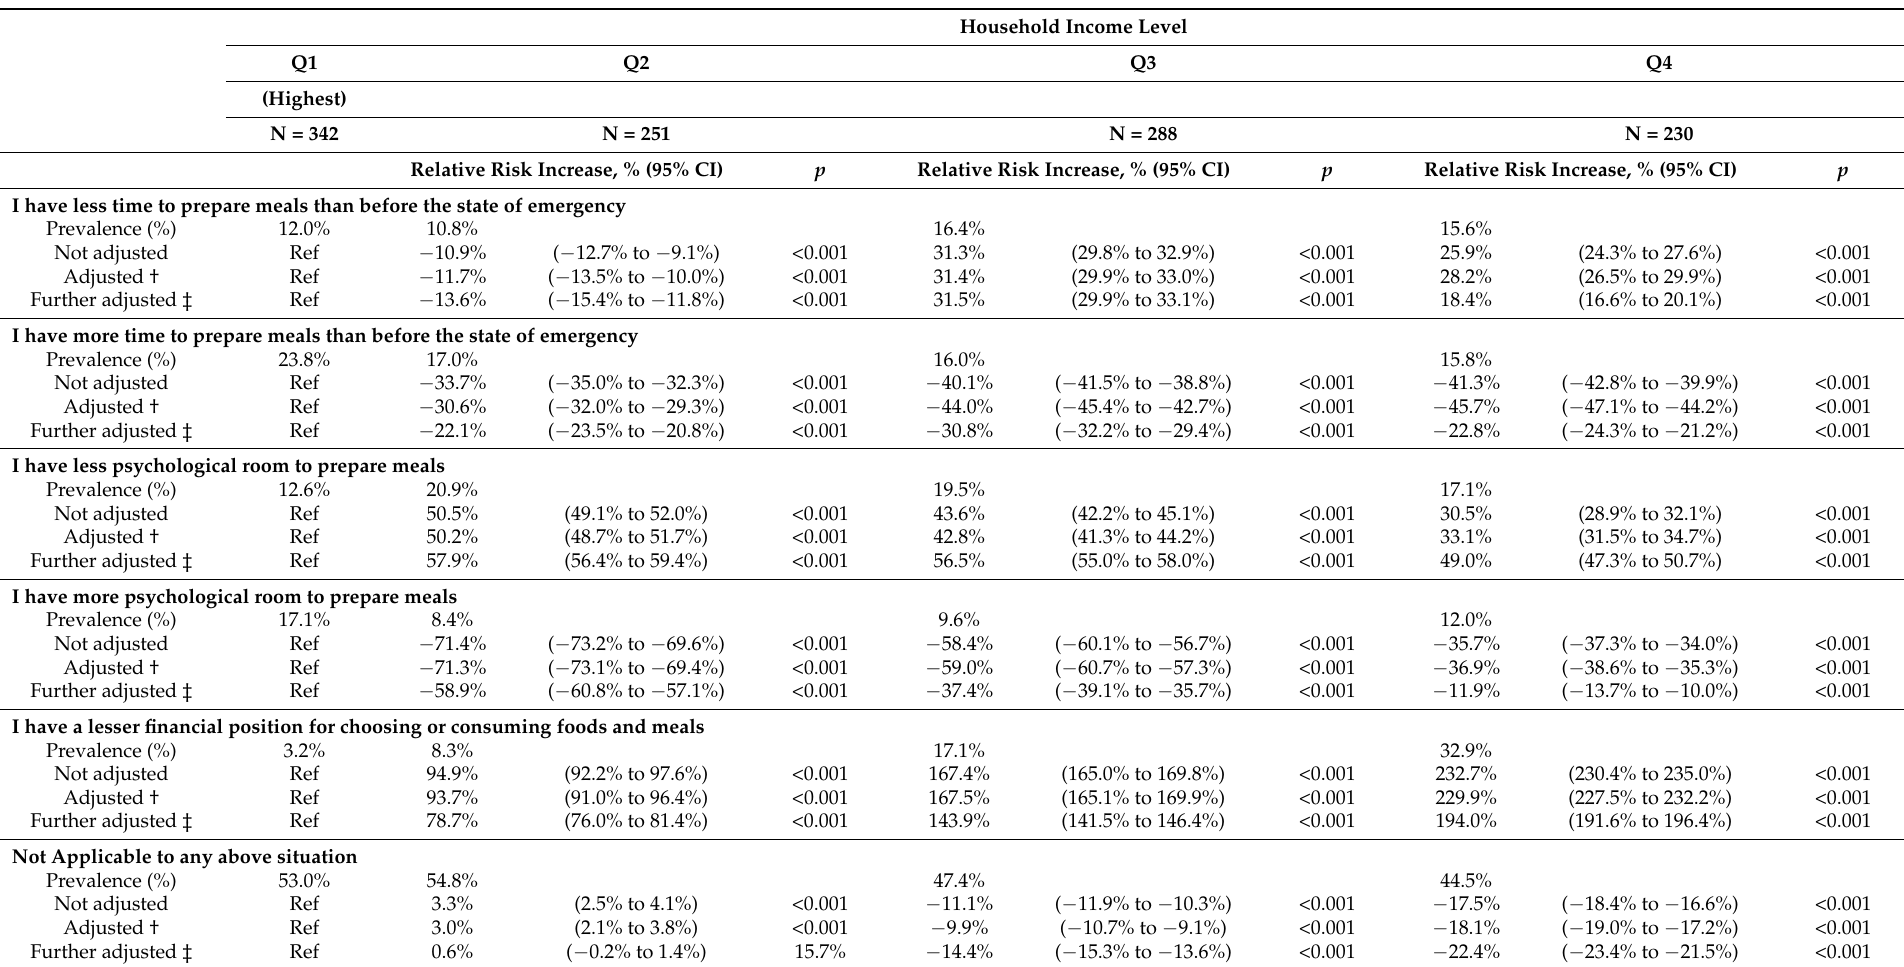
Table 5. Poisson regression analysis of household income level and the guardian’s subjective sense of burden for preparing meals for 10–14-year-old schoolchildren in Japan after COVID-19 state of